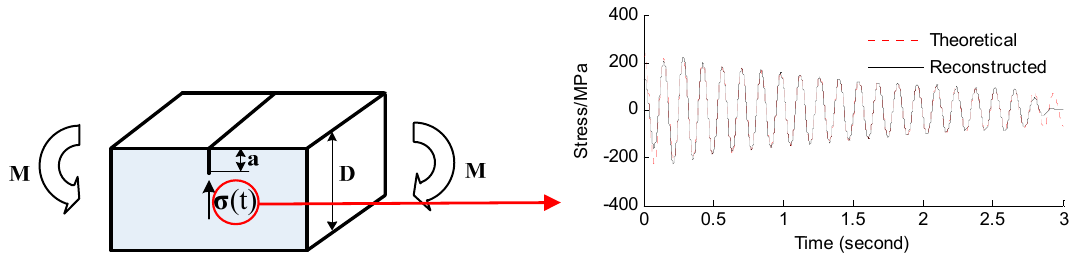
Figure 13. Single edge notch bending solid segment.